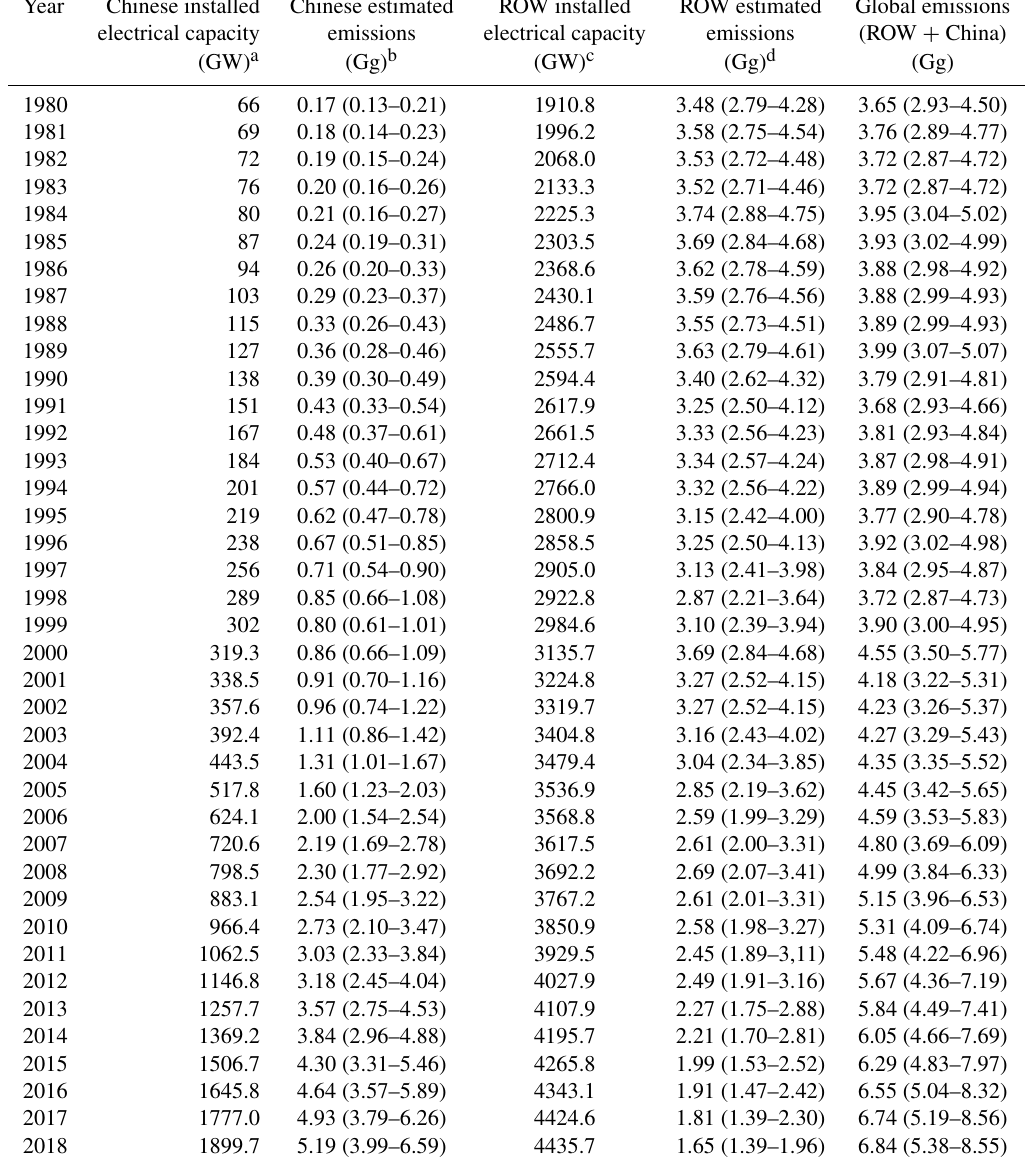
Table 1. Estimated SF 6 emissions (Gg) calculated from installed electrical capacity in China and the rest of the world